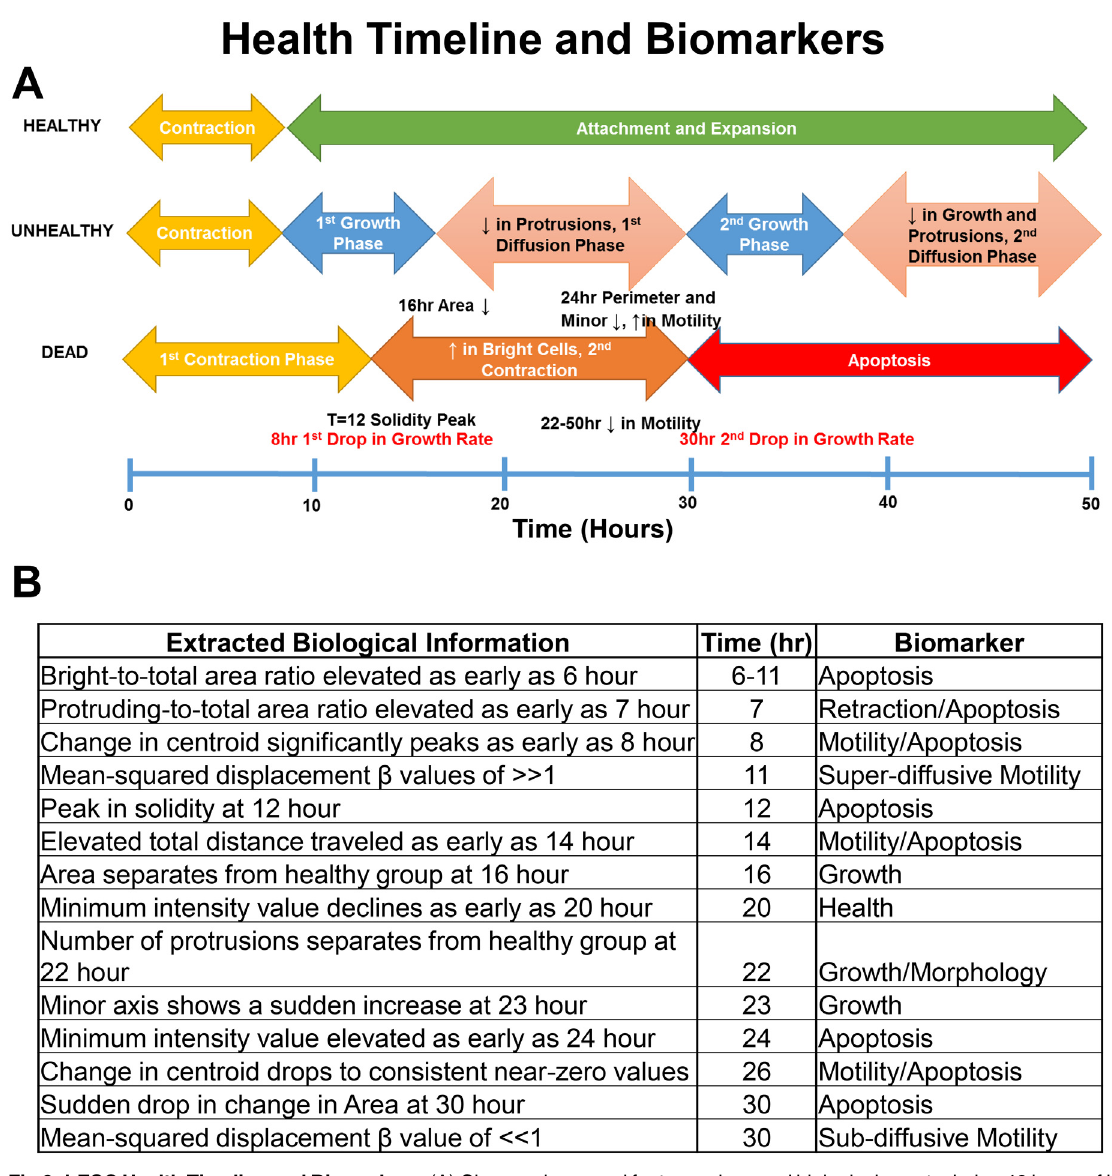
Fig 6. hESC Health Timeline and Biomarkers. (A) Changes in several feature values and biological events during 48 hours of incubation for healthy, unhealthy and control groups. This type of plot can be used to compare events in different groups. (B) Biomarkers that can be used to identify healthy, unhealthy, and dying colonies and their earliest detection